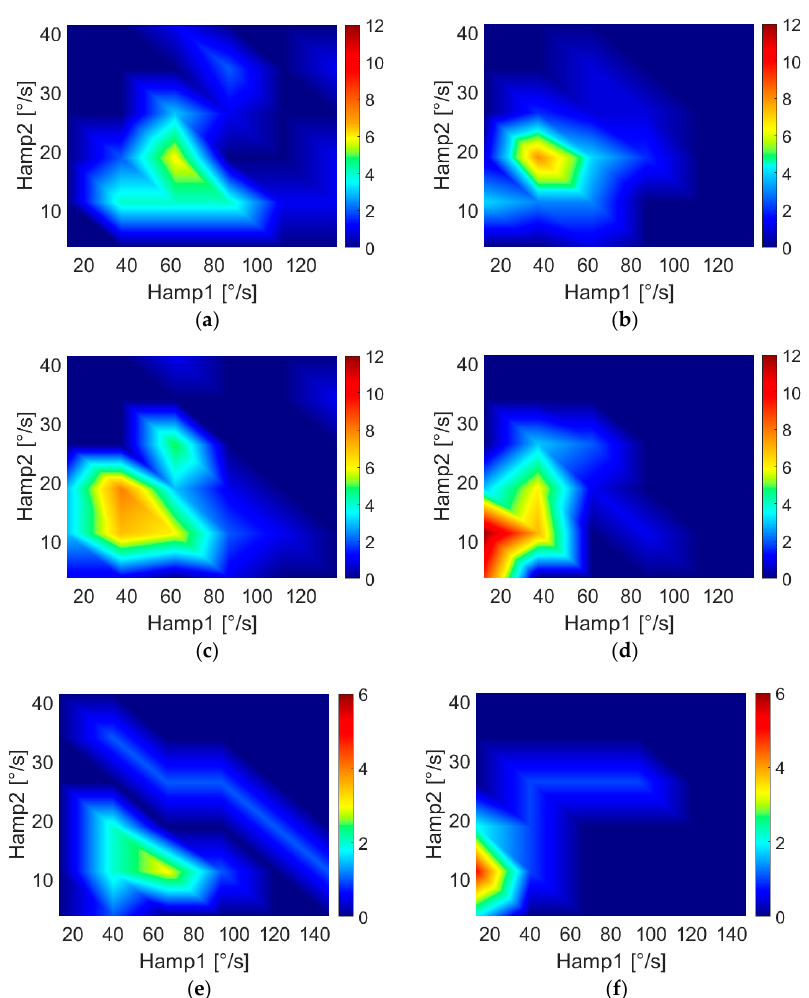
Figure 3. Two-dimensional features’ distributions for HC subjects (( a ) “least affected” side, ( b ) “most affected” side), PD-DN patients (( c ) “least affected” side, ( d ) “most affected” side) and PD-OFF patient € (( e ) “least affected” side, ( f ) “most affected” side). The colors are related to the number of subjects. Color bar limits of PD-OFF plots are lower with respect to the other plots because of the smaller population.